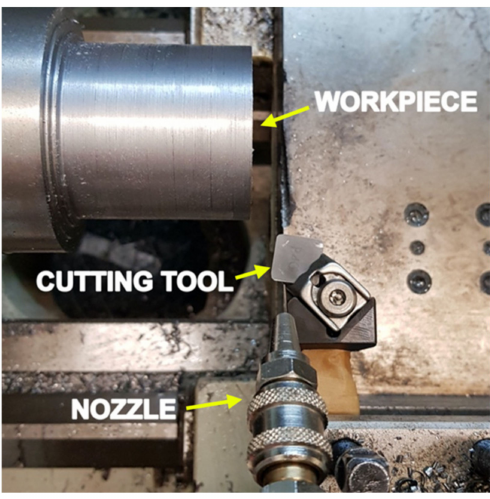
Figure 3. Experimental setup.